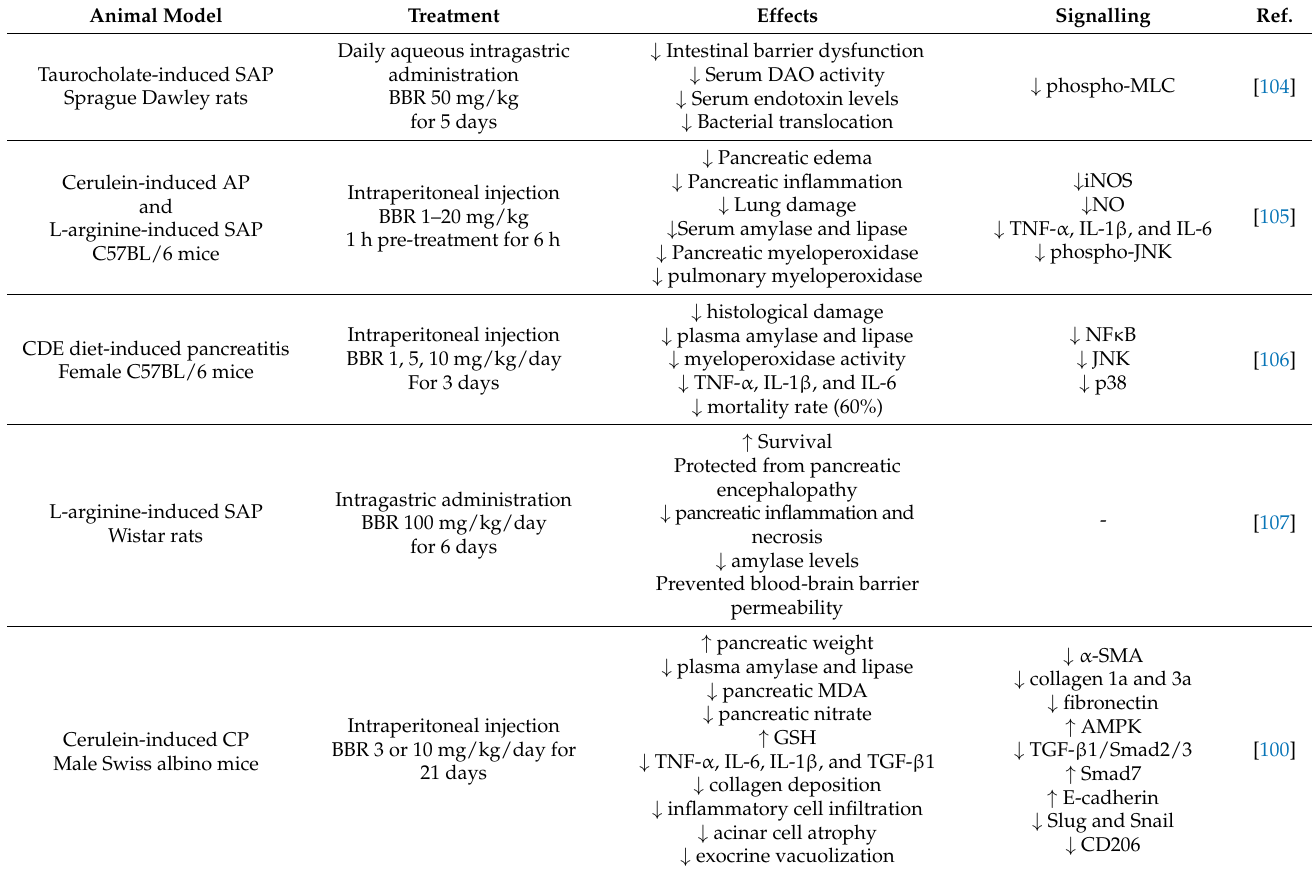
Table legend: ↑ increases, ↓